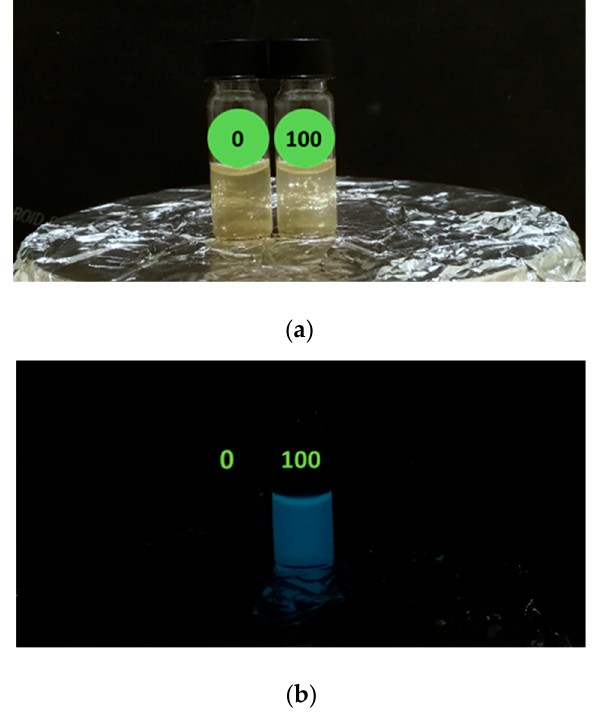
Figure 4 . Luminescent responsivity of 0 and 100 µg/L Hg 2+ treated E. coli reporter samples under Figure 4. Luminescent responsivity of 0 and 100 µ g / L Hg 2 + treated E. coli reporter samples under agitation: ( a ) light conditions; ( b ) dark conditions. agitation: ( a ) light conditions; ( b ) dark conditions.